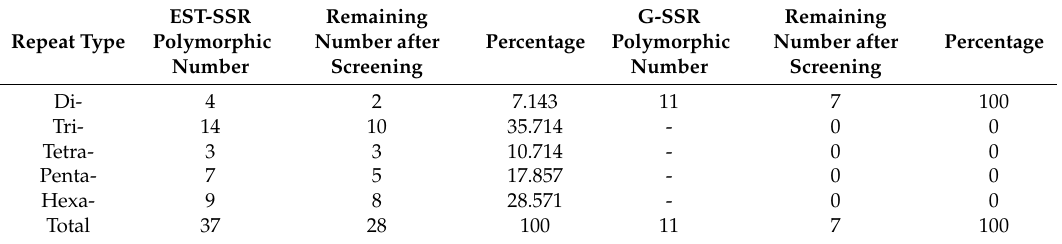
Table 1. Characteristics of expressed sequence tag-derived SSRs (EST-SSRs) and genomic DNA-derived SSRs (G-SSRs) markers in Robinia pseudoacacia L. individuals.